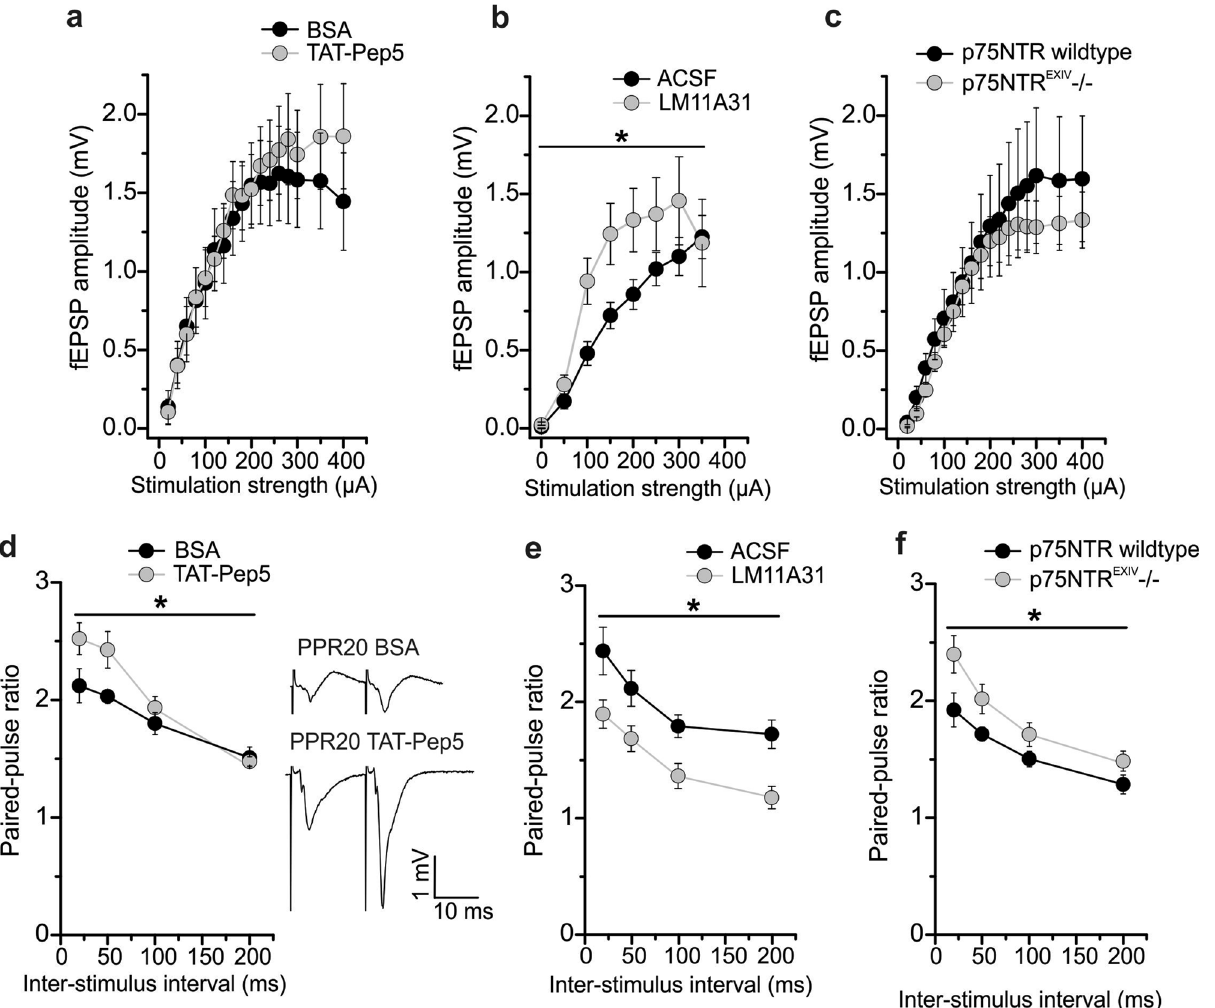
Figure 4. Influence of acute or chronic inhibition of p75NTR signaling on basal synaptic responses and short-term synaptic plasticity at hippocampal mossy fiber synapses. ( a ) and ( b ) input–output (IO) curve in the presence of 1 µM TAT-Pep5 ( a ) or 100 nM LM11A31 ( b ) for acute inhibition or modulation of MF-transmission. ( c ) IO curve in p75NTR EXIV−/− mice (chronic inhibition). ( d ) and ( e ) paired-pulse facilitation (PPF) at different inter-stimulus intervals of (20, 50, 100 and 200 ms) in the presence of TAT-Pep5 ( d ) or LM11A31 ( e ). The inset displays representative averaged original responses for PPF at an ISI of 20 ms for BSA and TAT-Pep5. Scale bars are shown in the inset. ( f ) PPF in p75NTR EXIV−/− mice. Data expressed as mean ± SEM. *p < 0.05